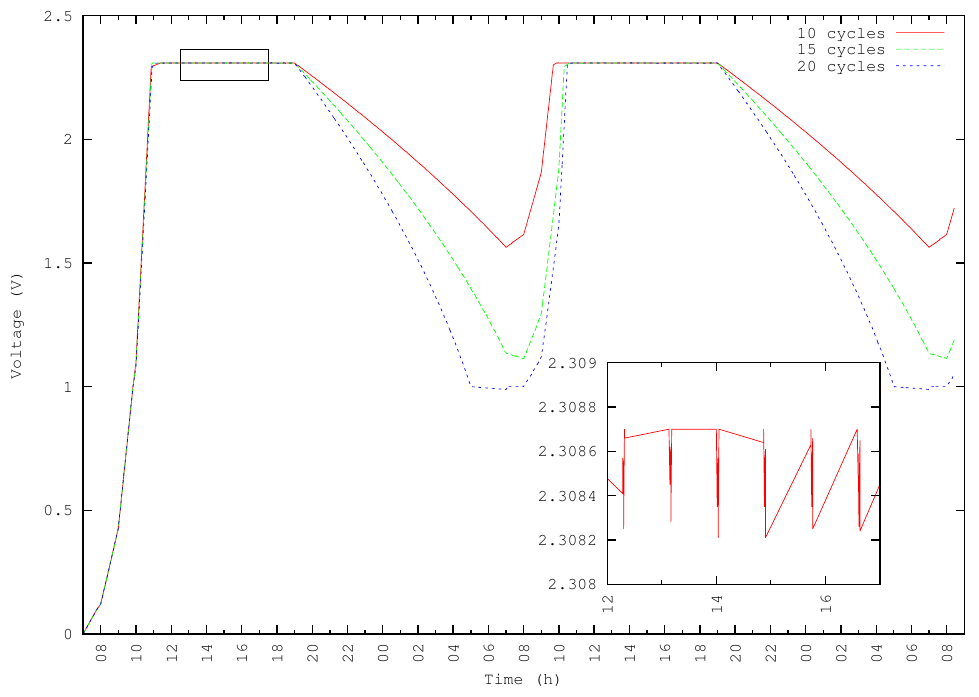
Figure 7. TX/RX cycles